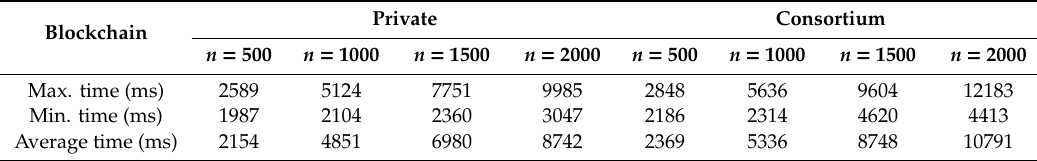
Table 3. The publishing time